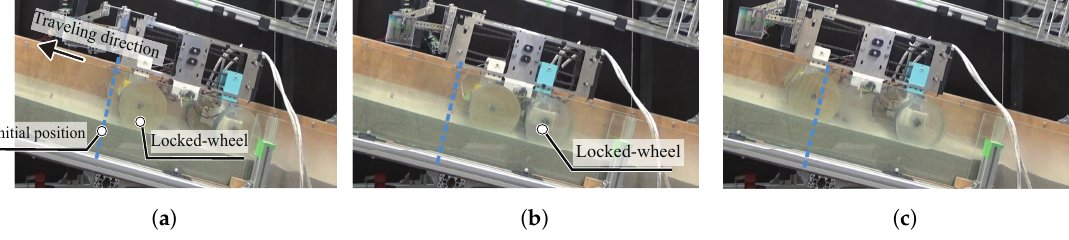
Figure 2. Actual image of traveling experiment on soil: The rover firstly shrinks its wheel-base, and the front wheel is fixed to the ground and supports the rear wheels’ motion ( a , b ). Next, the rover extends its wheel-base, and the rear wheel is also fixed to the ground and supports the front wheels’ motion ( b , c ).